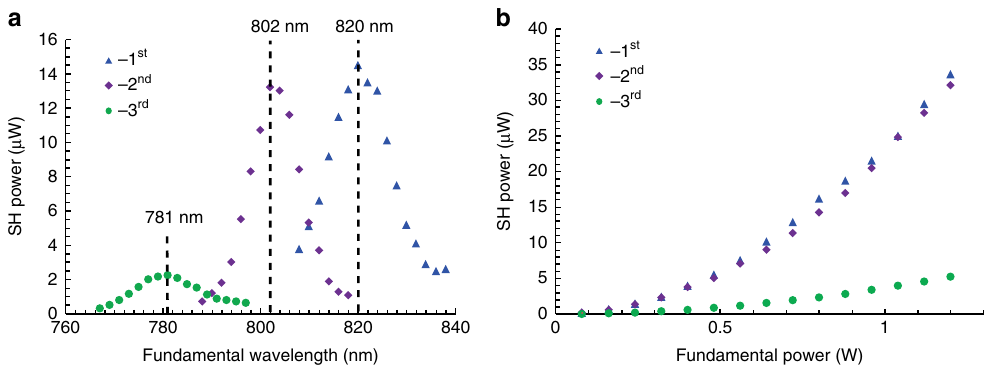
Fig. 3 Ef fi cient SH vortex beam shaping. a Dependence of output powers of the 1st, 2nd, and 3rd diffraction orders on pump wavelength. The pump power is kept at 0.8 W. The peak values indicate the effect of QPM. b Dependence of output powers of the 1st, 2nd, and 3rd diffraction orders on pump power at the QPM wavelengths of 820 nm, 802 nm, and 781 nm,